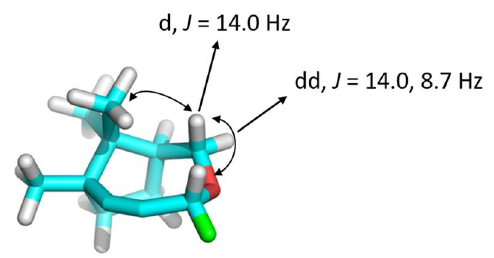
Figure 1. 3D structural model of cyclooctyne ( R )- 1 . Black arrows indicate nuclear Overhauser effects (NOEs), and the alkyl group is represented in green color.